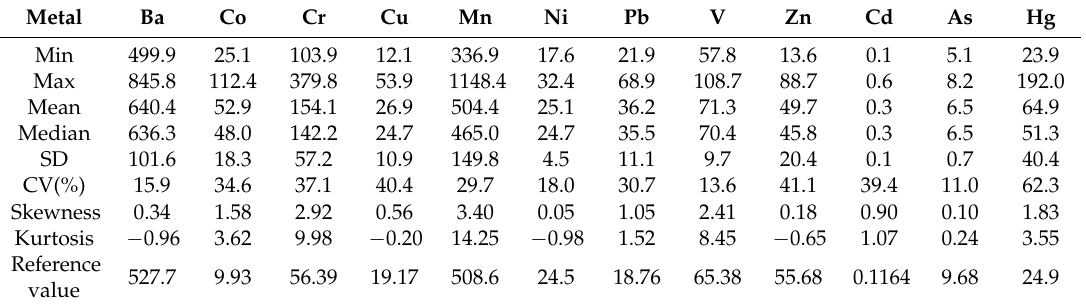
Table 1. Metal concentration in dust collected from urban square and park of Baotou city